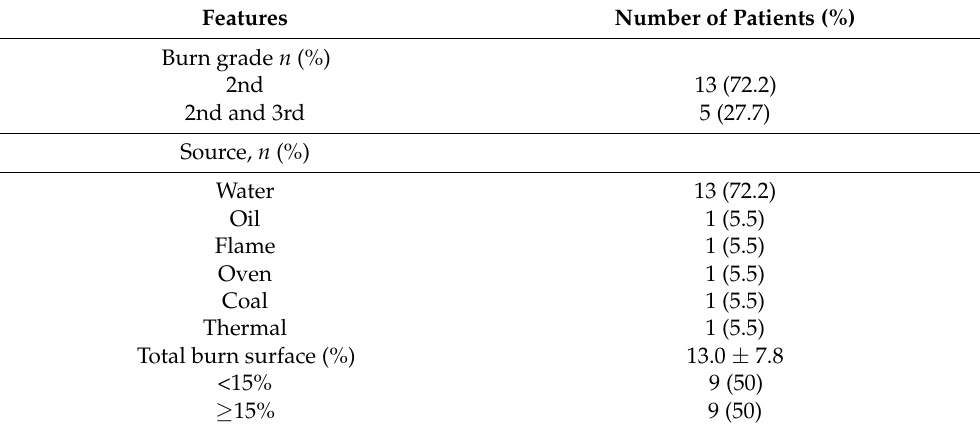
Table 3. Features of the